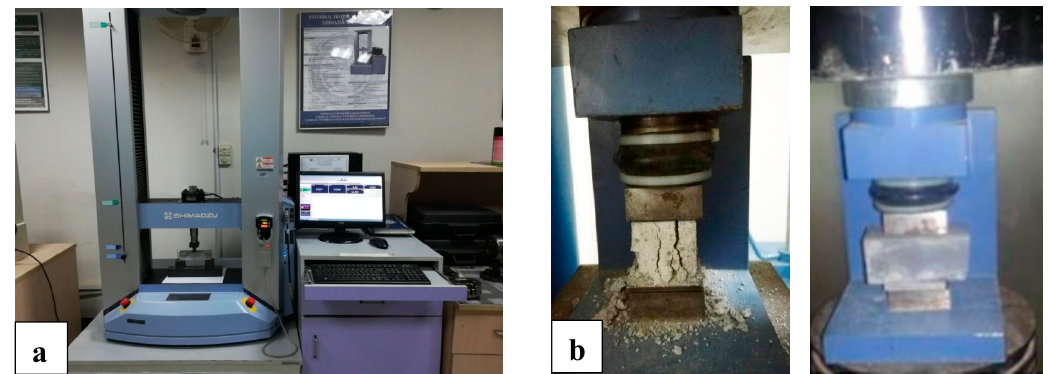
Figure 7. ( a ) Flexural response of nanocomposite, ( b ) compression response of nanocomposite.